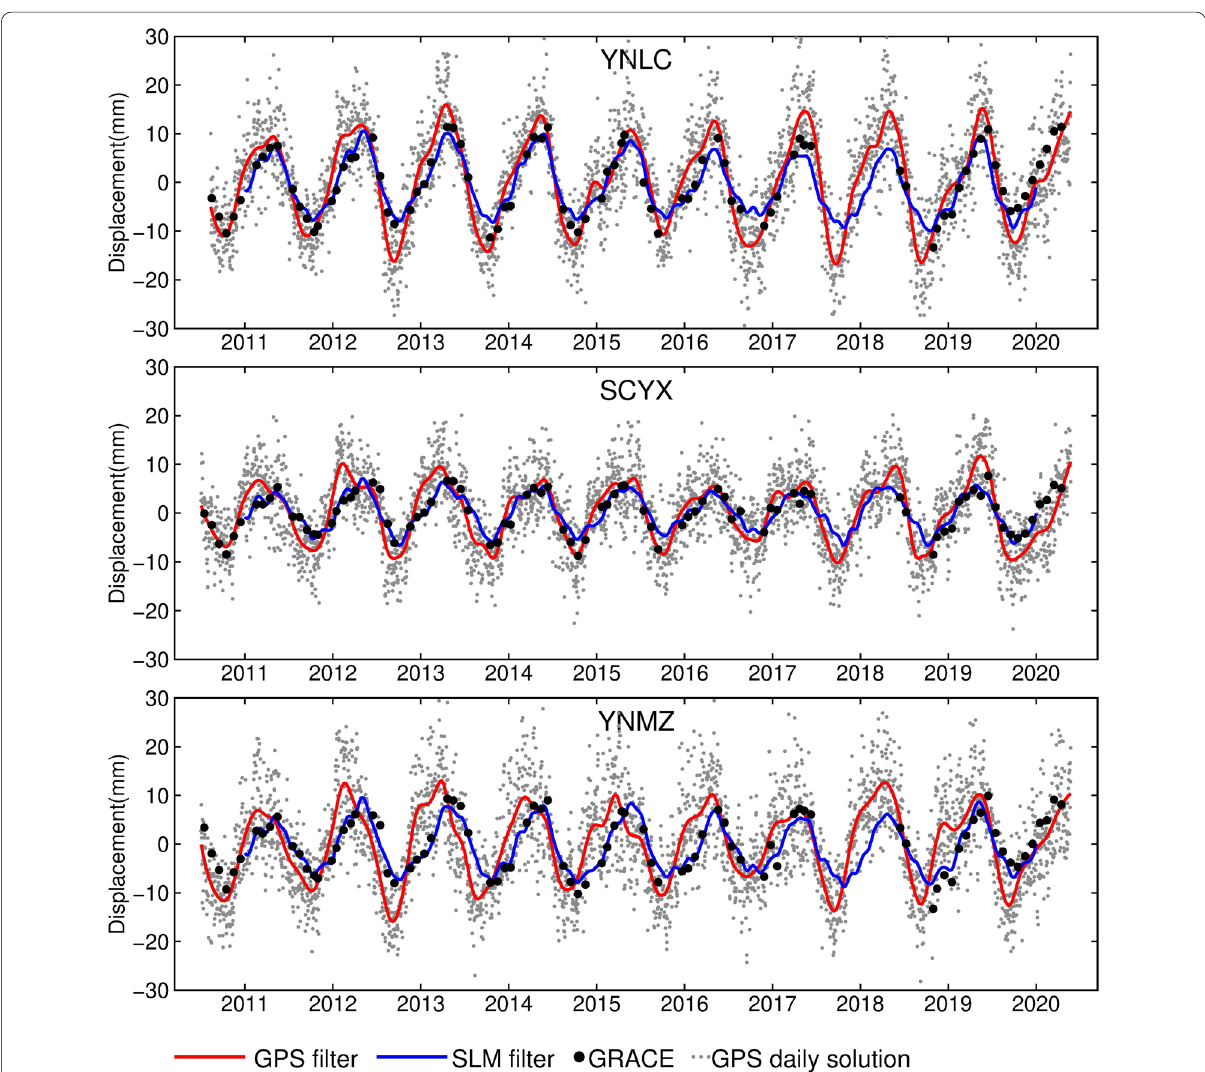
Fig. 5 Seasonal vertical deformation time series derived by global positioning system (GPS) stations, gravity recovery and climate experiment (GRACE), and surface loading model (SLM) at YNLC, SCYX, and YNMZ